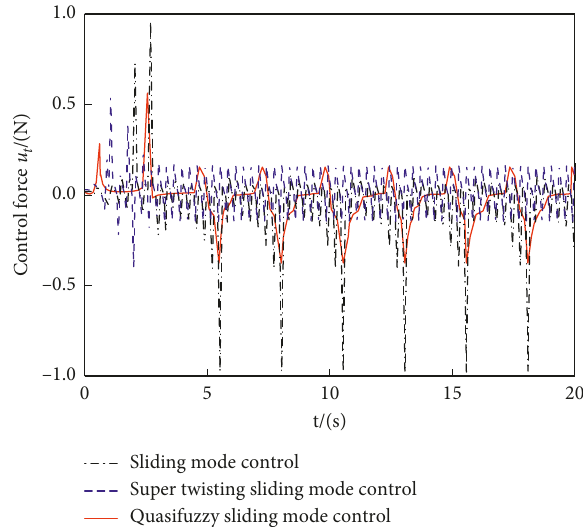
Figure 9: Fuzzy sliding mode control